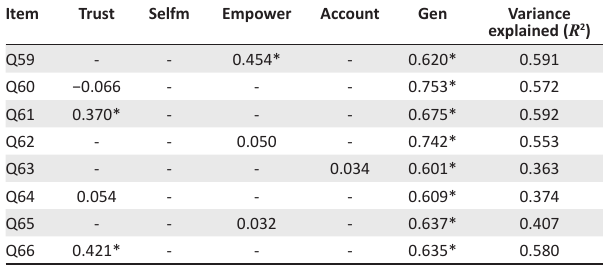
TABLE 4 (Continues...): Completely standardised LAMBDA-X factor loadings of the bi-factor measurement